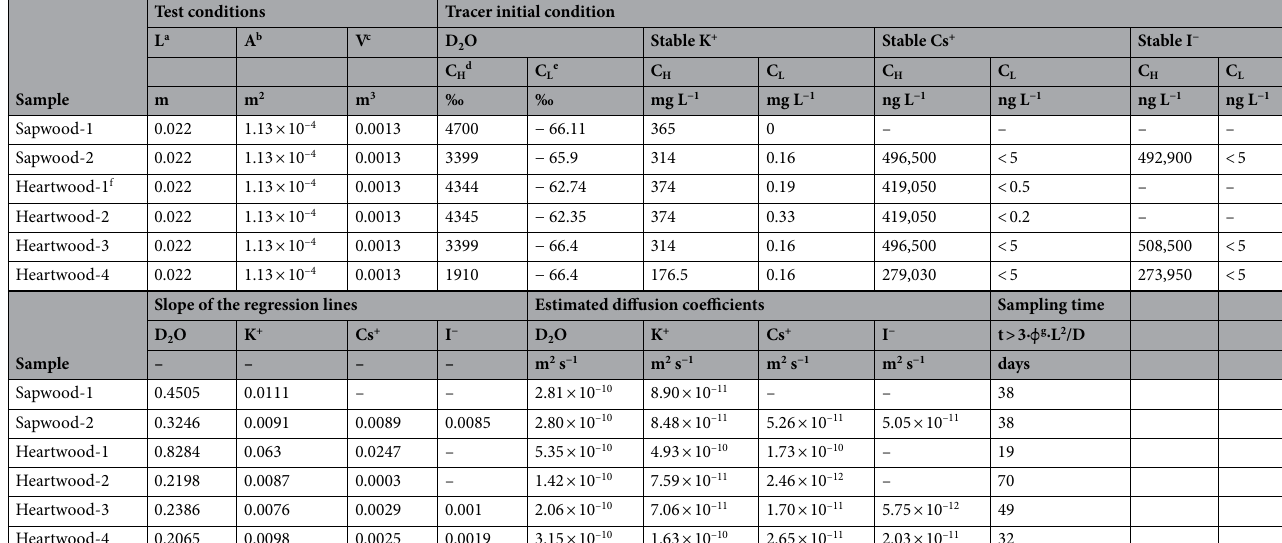
Table 1. Diffusion test conditions and the estimated diffusion coefficients for D 2 O, K + , Cs + , and I − in sugi xylem (sapwood and heartwood). a Length of the sample. b Section area. c Volume of the tank. d Initial concentration in the tracer tank. e Background concentration of the tracer in the diffusing tank. f This heartwood sample had visible ray parenchyma. g The average porosity of xylem sample; 0.627 in sapwood, 0.587 in